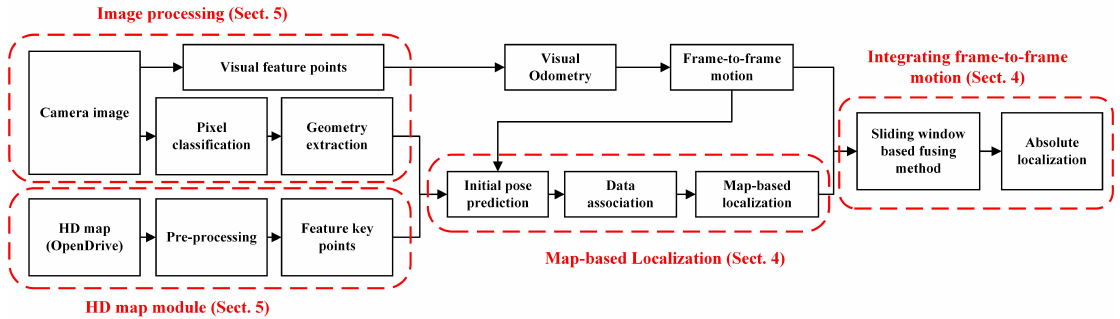
Figure 2. Overview of the proposed method—Monocular Localization with Vector HD map